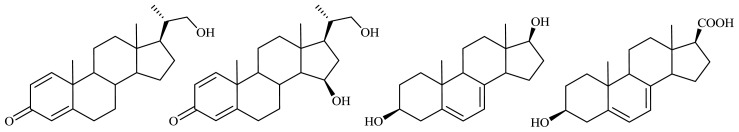
Products of microbiological degradation of sterols and their derivatives with proven biological activity.